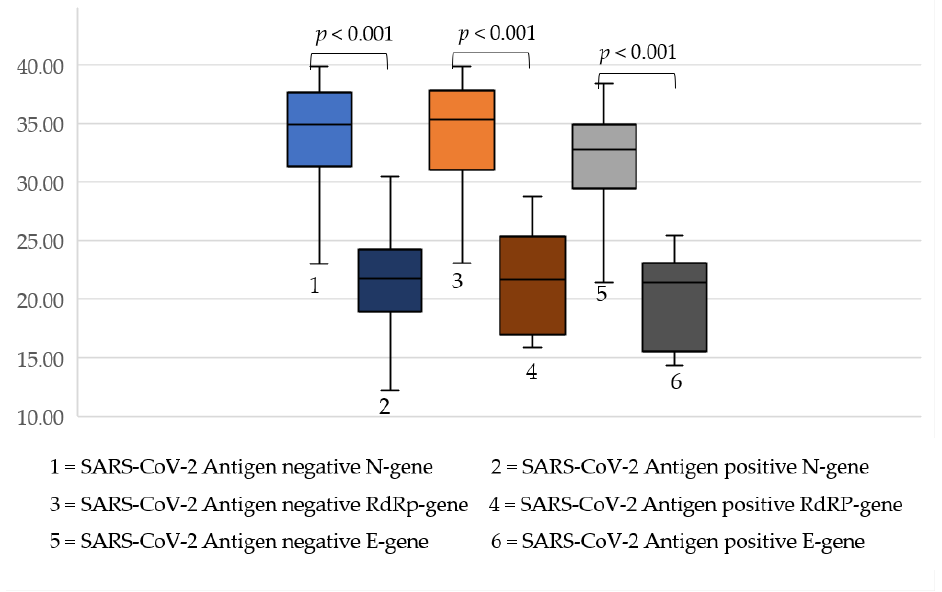
Figure 1. Distribution of the different Ct values from people who tested either RAT+ or RAT − . In our study, ROC curves and Youden’s index analyses indicated that for the N-, E- and RdRP-gene, the optimum cut-off of the different Ct values which discriminated best between RT-PCR+/RAT+ and RT-PCR+/RAT − subjects, were <30, <25 and <30 respectively. The sensitivities were 100% (N- and RdRP-gene) and 88.9% (E-gene). The specificities were 78.6%, 92.9% and 78.6% (Figure 2).